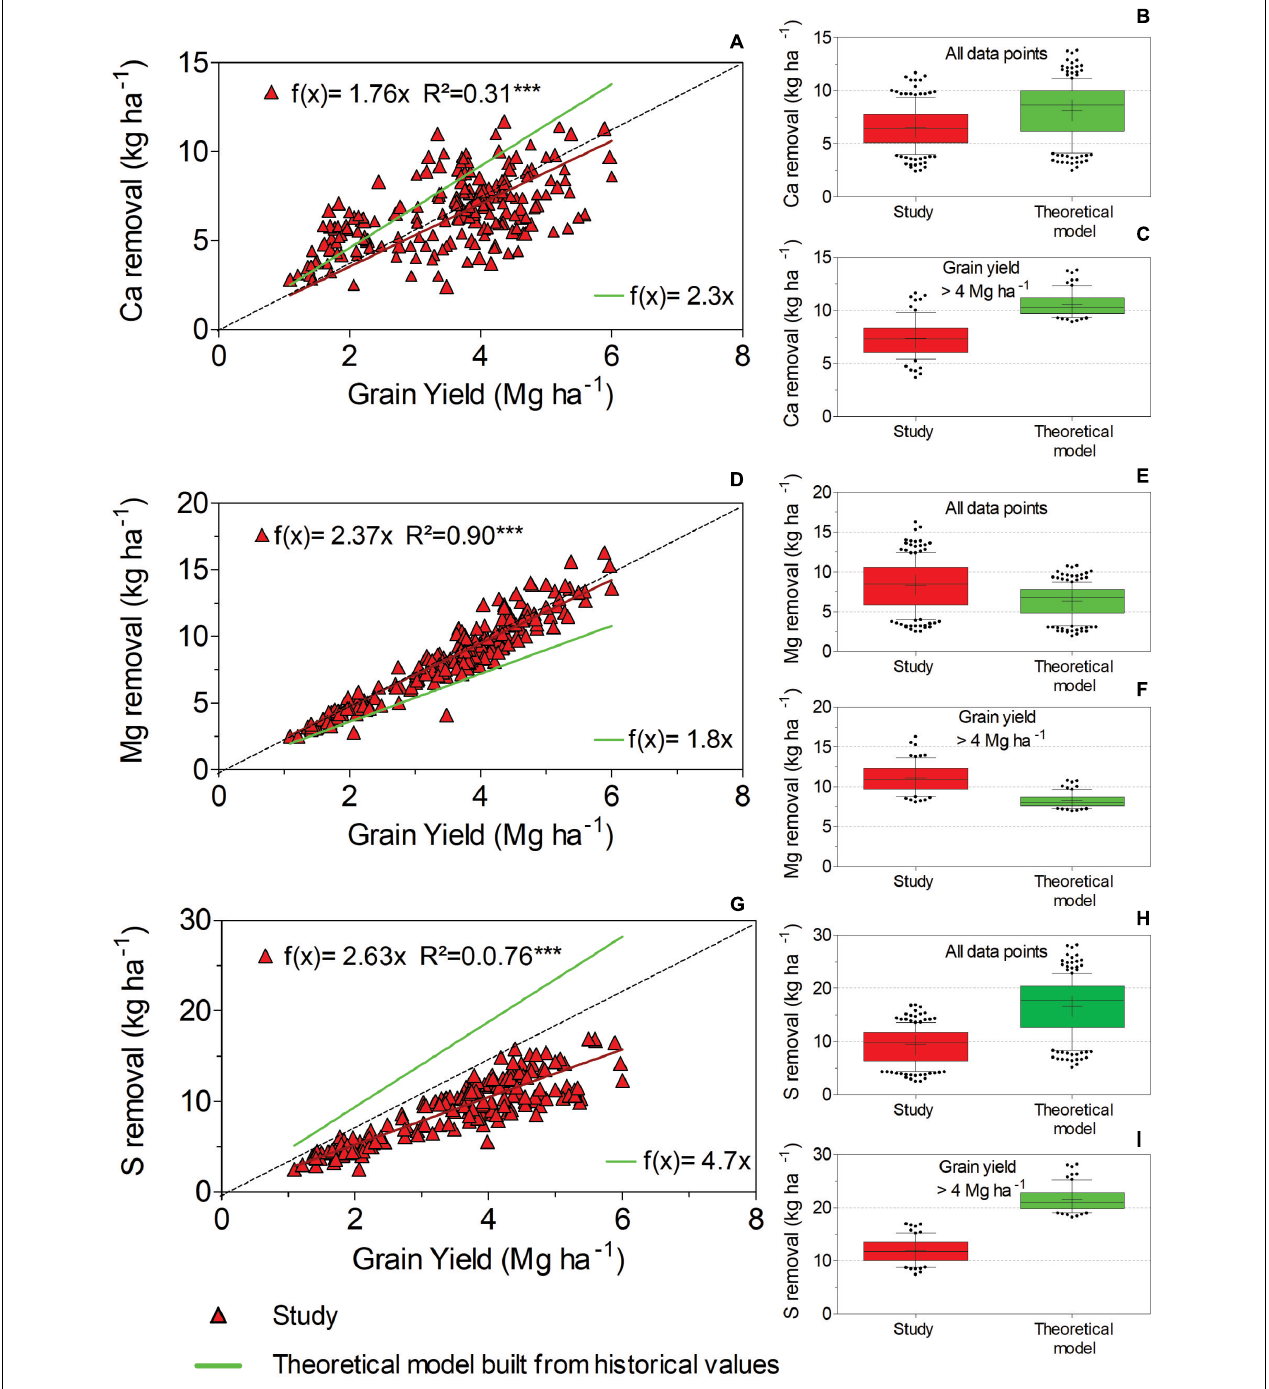
FIGURE 5 | Linear functions to describe (A) Ca, (D) Mg, and (G) S removal relative to grain yield. Differences among the datasets were tested using an F test ( p < 0.05). The box plots display the data distribution of the overall yield for (B) Ca, (E) Mg, and (H) S removal by harvest. Box plots (C) , (F) , and (I) display